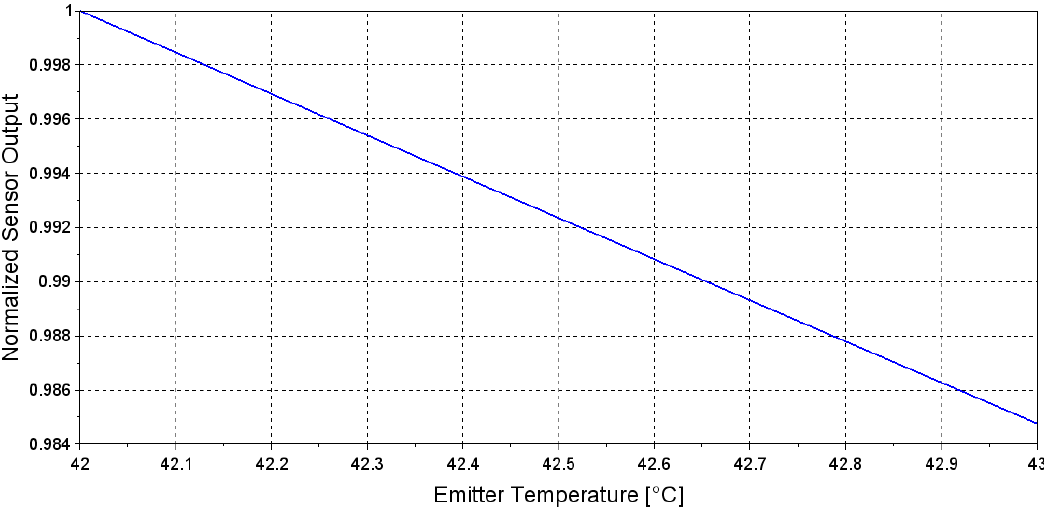
Figure 12. Theoretical evaluation of correlation between sensor’s output and emitter element temperature, using sensor optopair